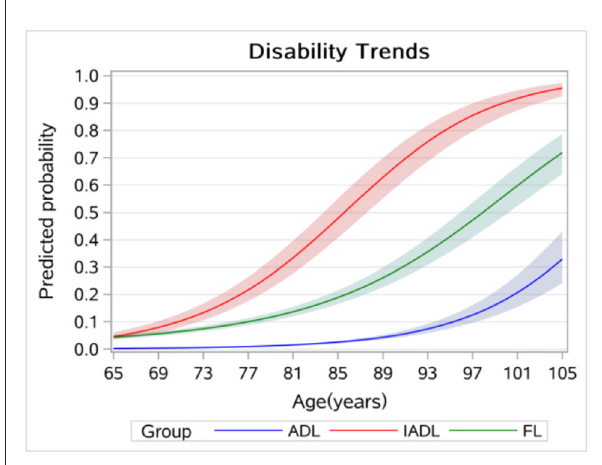
FIGURE1 Age trends in disabilities among older adults.